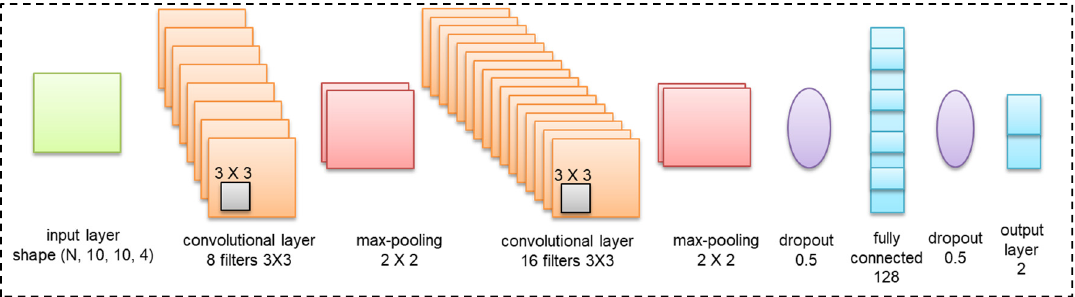
Figure 5. The CNN architecture.